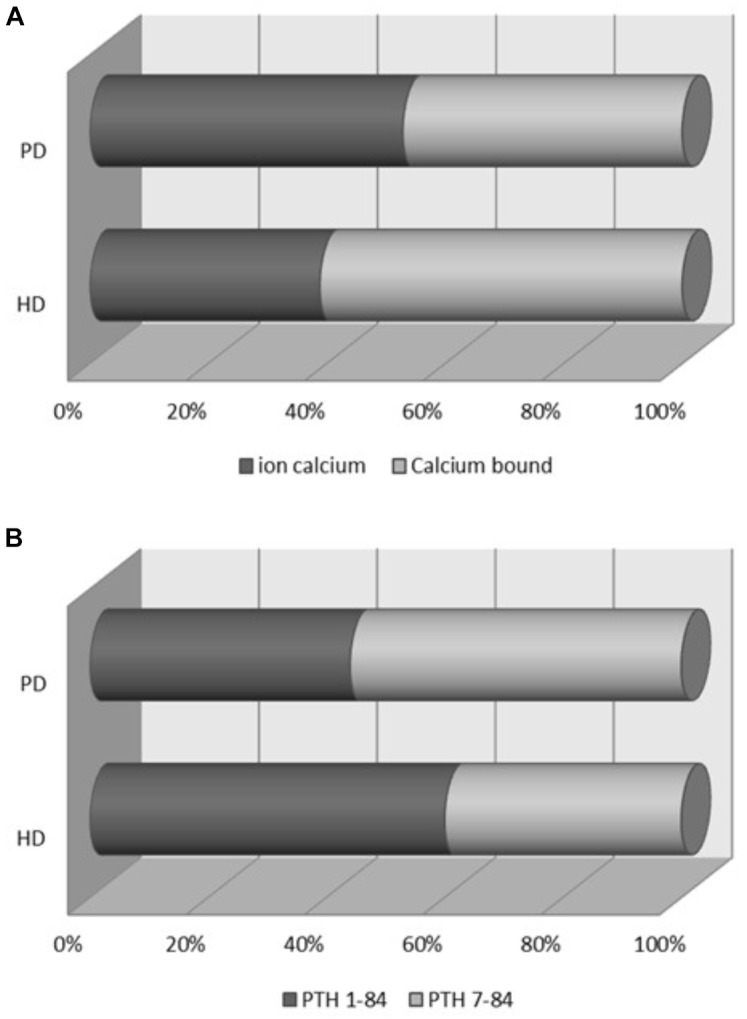
(A) Distribution of calcium ion and calcium bound expressed as percentage of total calcium. iCa accounted for 39% of tCa in the HD group and for 53% of tCa in PD patients, P < 0.001. (B) Distribution of circulating PTH fragments (1-84 PTH and non- 1-84 PTH) expressed as percentage of intact PTH (1-84 PTH plus non-1-84 PTH). Percentage of 1-84 PTH in PD patients (44.0 ± 12.28%) vs. HD patients (60.3 ± 10.82%), p < 0.001. HD, hemodialysis; PD, peritoneal dialysis.